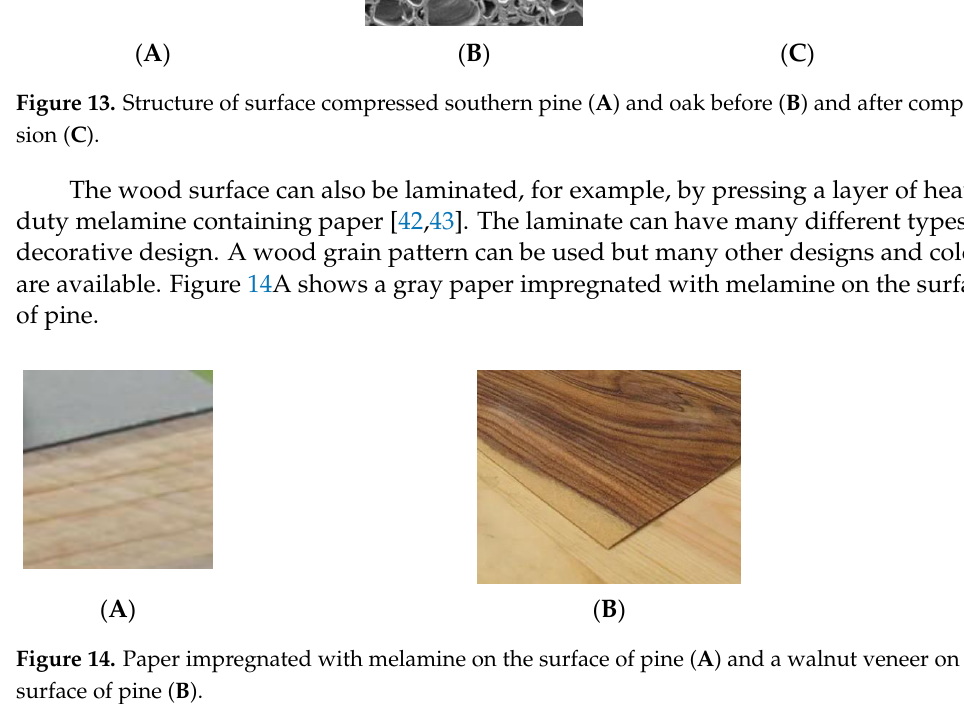
Figure 13. Structure of surface compressed southern pine ( A ) and oak before ( B ) and after compres- sion ( C ).